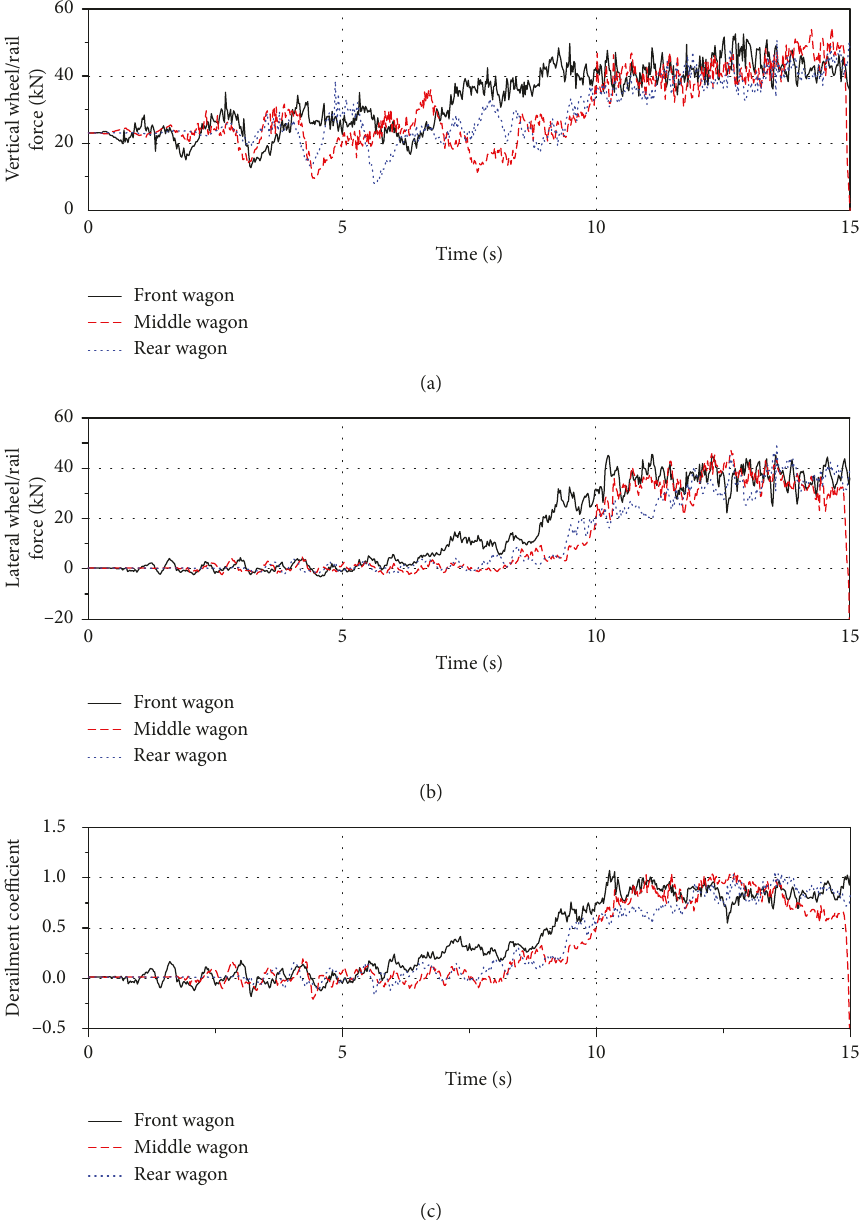
Figure 16: The comparison of dynamic performances: (a) vertical wheel/rail force; (b) lateral wheel/rail force; (c) derailment